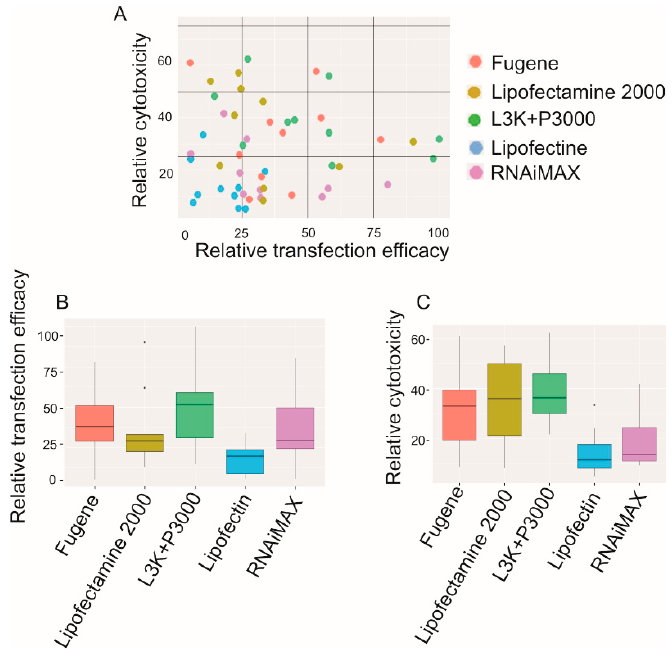
Figure 13. Relative transfection and cytotoxicity patterns of different transfection reagents. ( A ) the overall transfection efficacy and toxicity of each transfection reagent; ( B ) the relative transfection efficacy of each reagent, demonstrated as median; ( C ) the relative cytotoxicity of each reagent, demonstrated as median. L3K: Lipofectamine 3000.